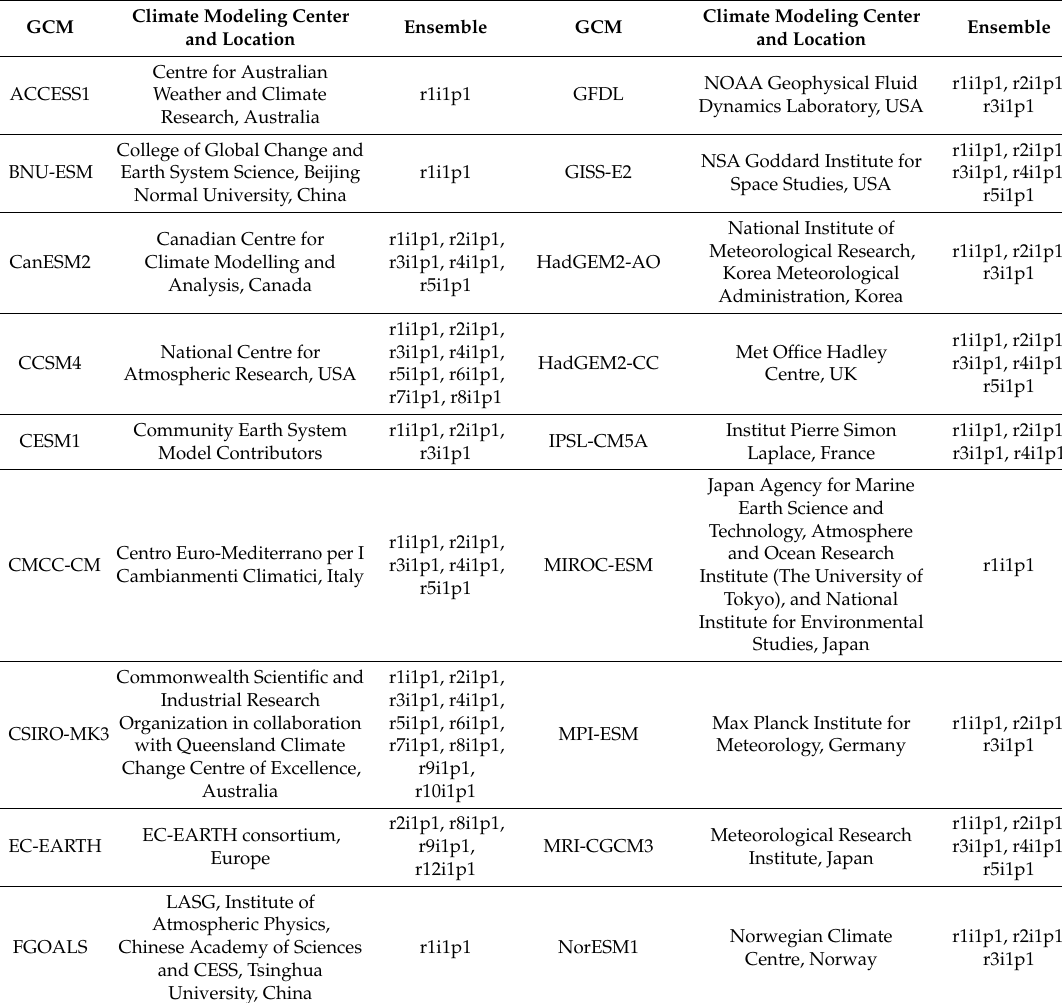
Table 2. Base GCMs used in this